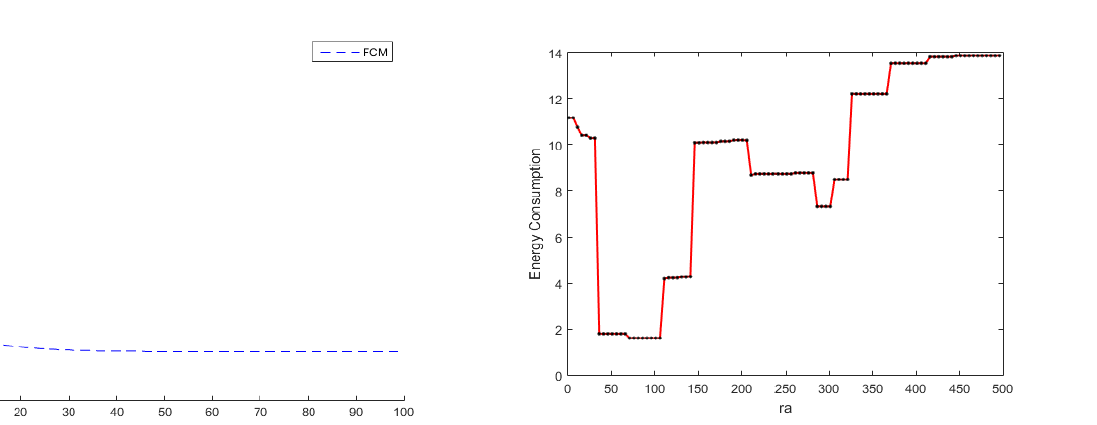
Figure 5. Relationship between Neighbourhood radius ( r a ) in Fuzzy Subtractive clustering and cost function (energy consumption)